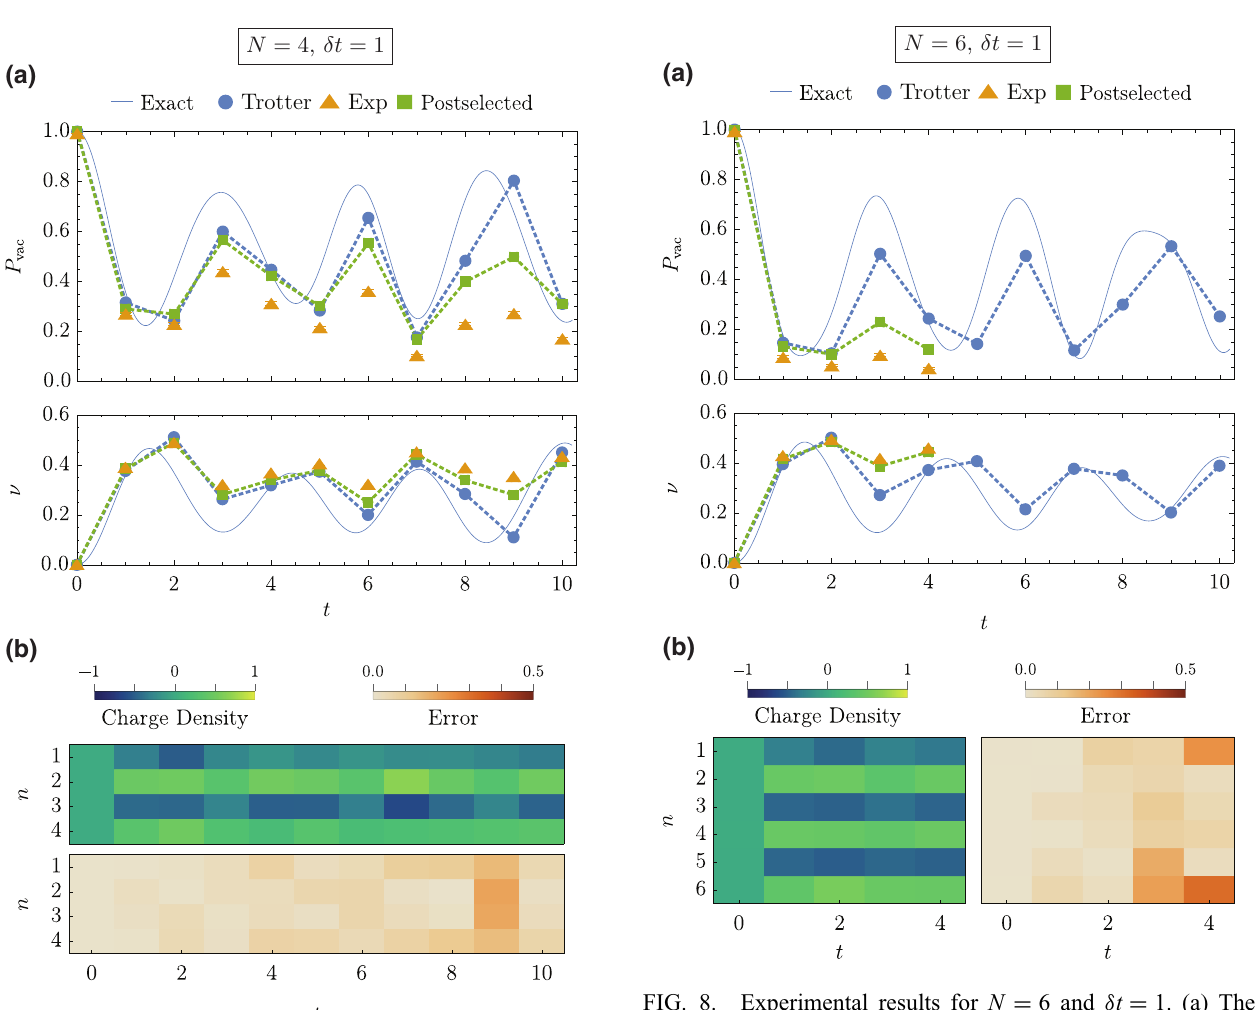
FIG. 8. Experimental results for N = 6 and δ t = 1. (a) The upper plot shows fluctuation in the bare-vacuum population, P vac ( t ) , while the lower plot shows the particle-number den- sity, ν( t ) . (b) The left-hand plot shows the local charge density Q n ( t ) as measured in the experiment after postselection, while the right-hand plot shows its deviation from theory. At t = 4, we ( t ) as n reach the gate-depth limit of the